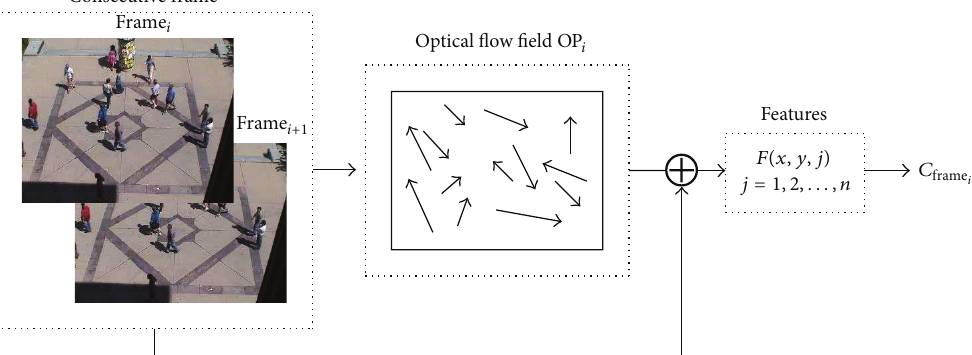
Figure 2: Covariance descriptor computation of a video